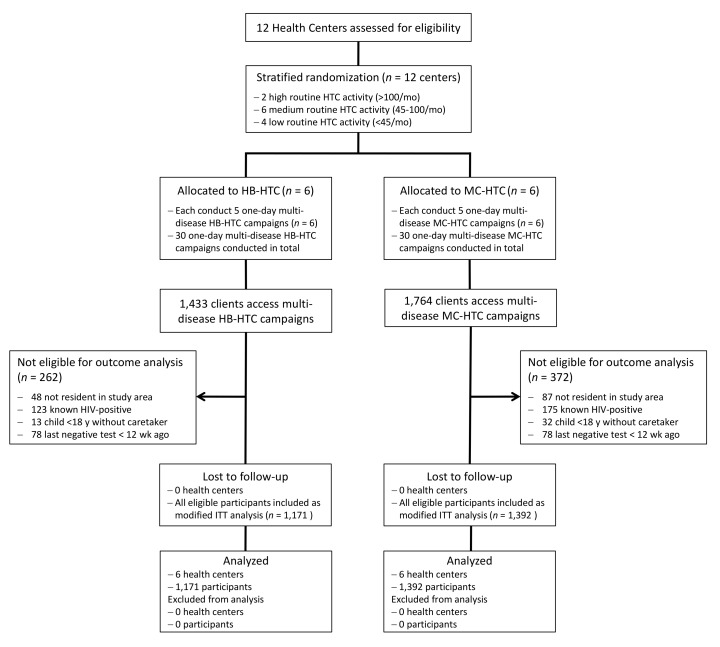
Consort chart of the study.One health center with its catchment area formed a cluster. ITT, intention to treat.